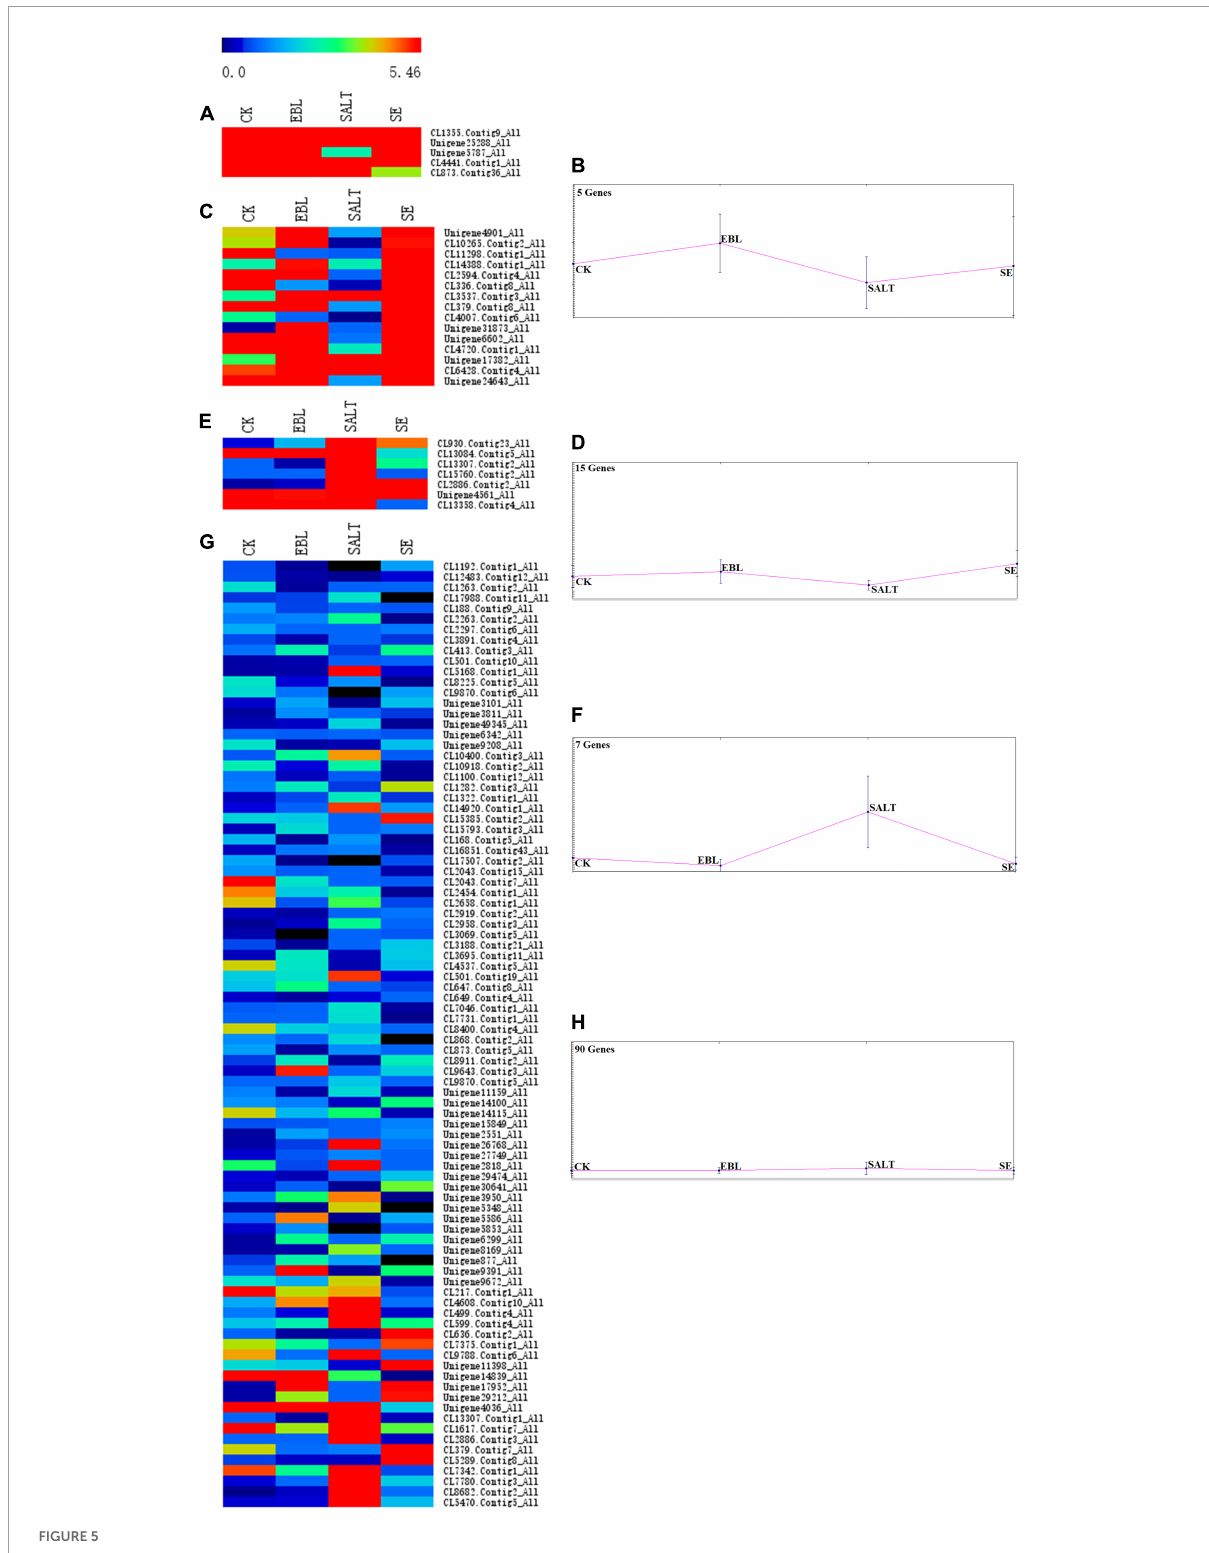
FIGURE5 Trend analysis of DEG expression in four groups. (A) Heatmap of gene expression in cluster 1; (B) Trend graph of gene expression in cluster 1; (C) Heatmap of gene expression in cluster 2; (D) Trend graph of gene expression in cluster 2; (E) Heatmap of gene expression in cluster 3; (F) Trend graph of gene expression in cluster 3; (G) Heatmap of gene expression in cluster 4; (H) Trend graph of gene expression in cluster